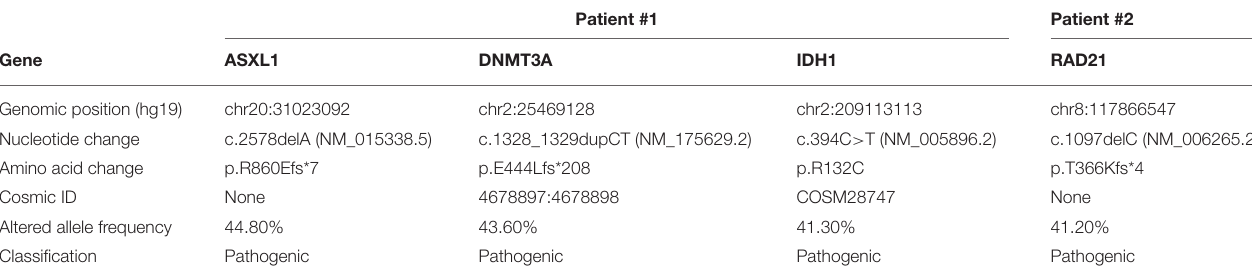
TABLE 2 | Hematologic malignancy gene panel findings in two patients with variant t(8;21). Patient #1 Patient